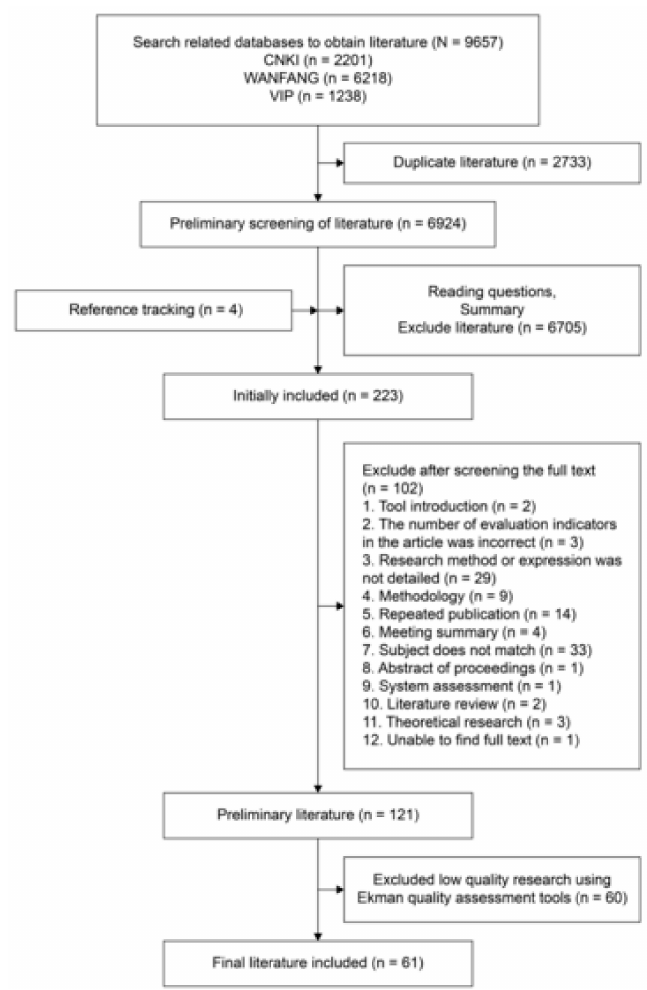
Figure 1. Flow chart of study selection